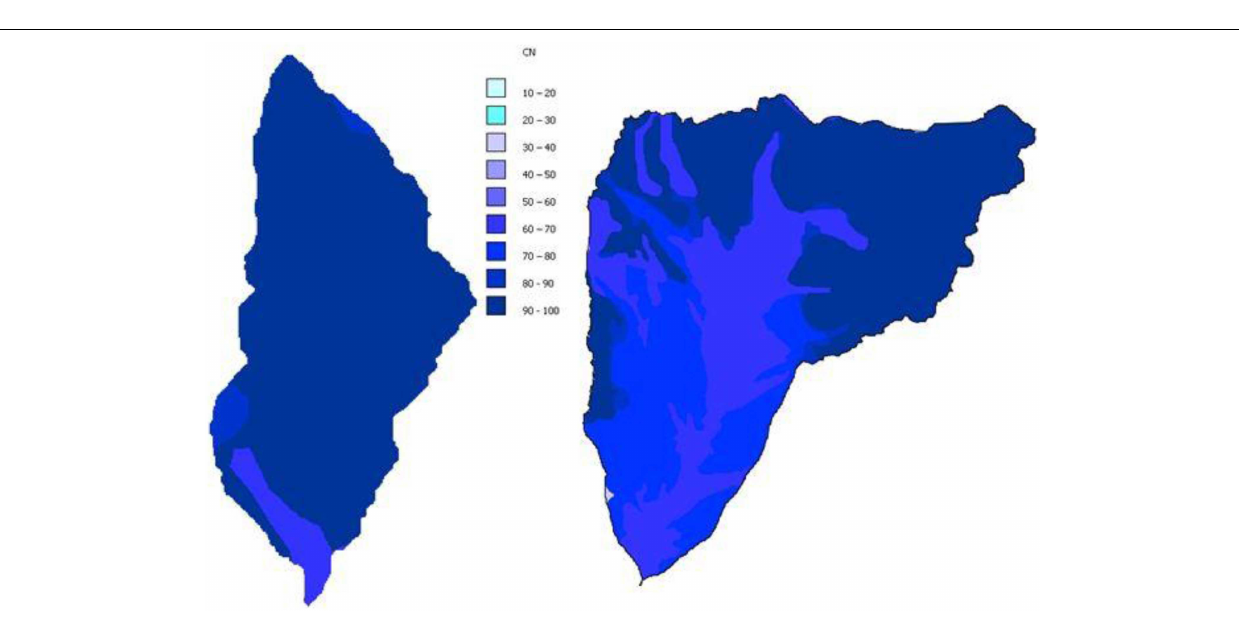
and simulated peak discharges (h 5 is the rainfall precipitated in the previous 5